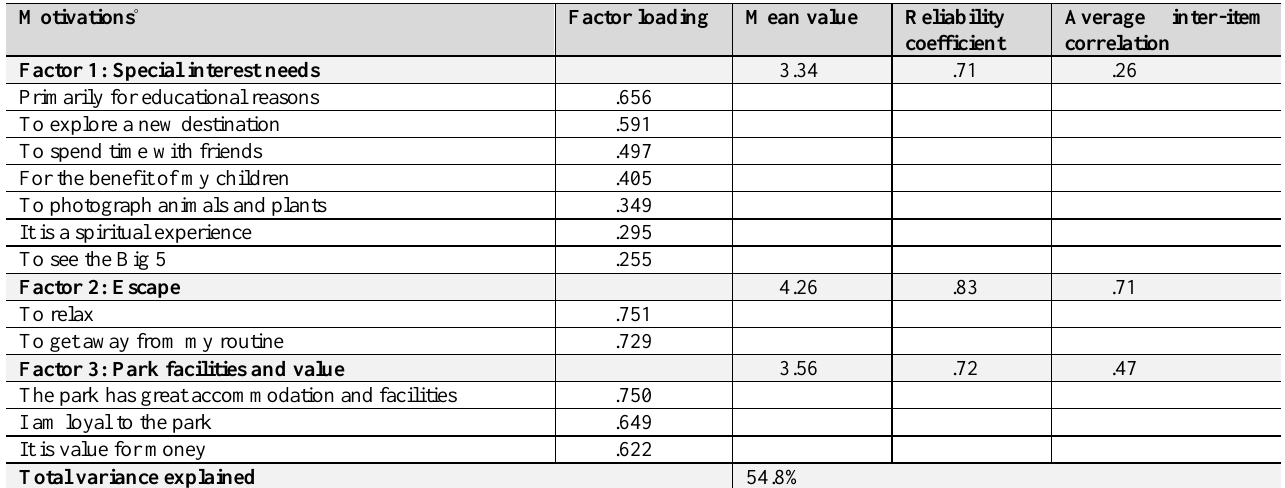
Table 2: Results of the factor analysis on the motivations of respondents to visit the Kruger National Park Motivations ◦